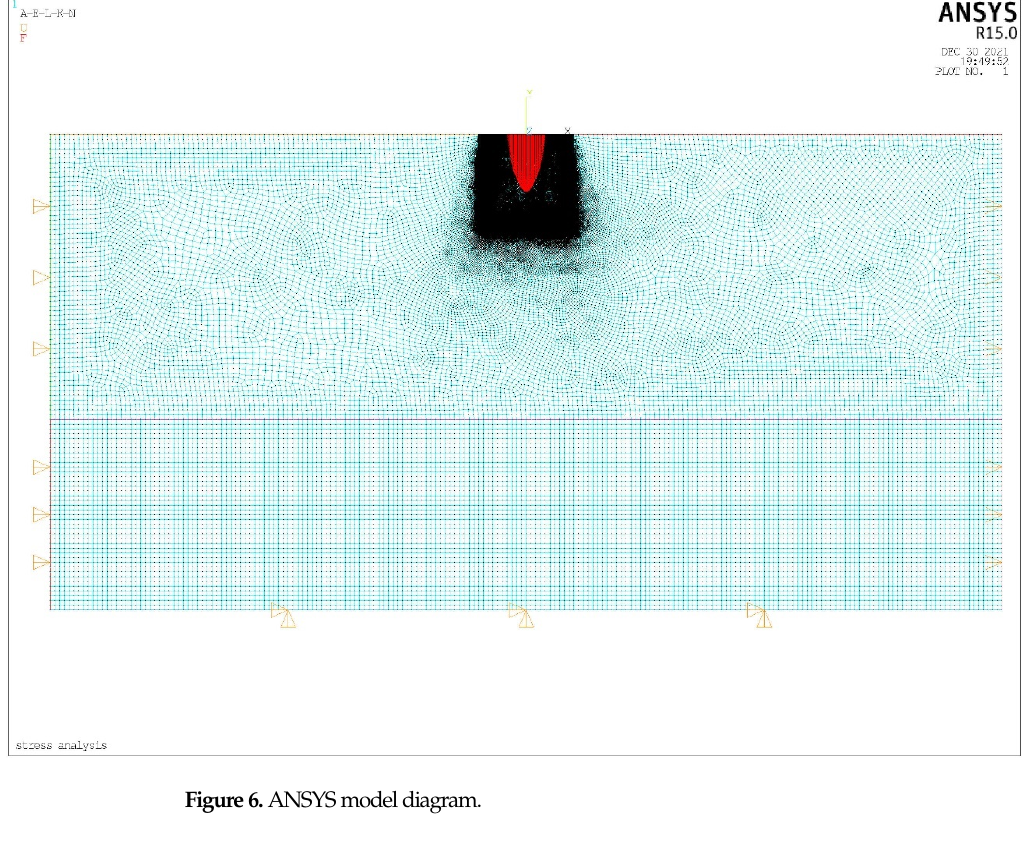
Figure 6. ANSYS model diagram.